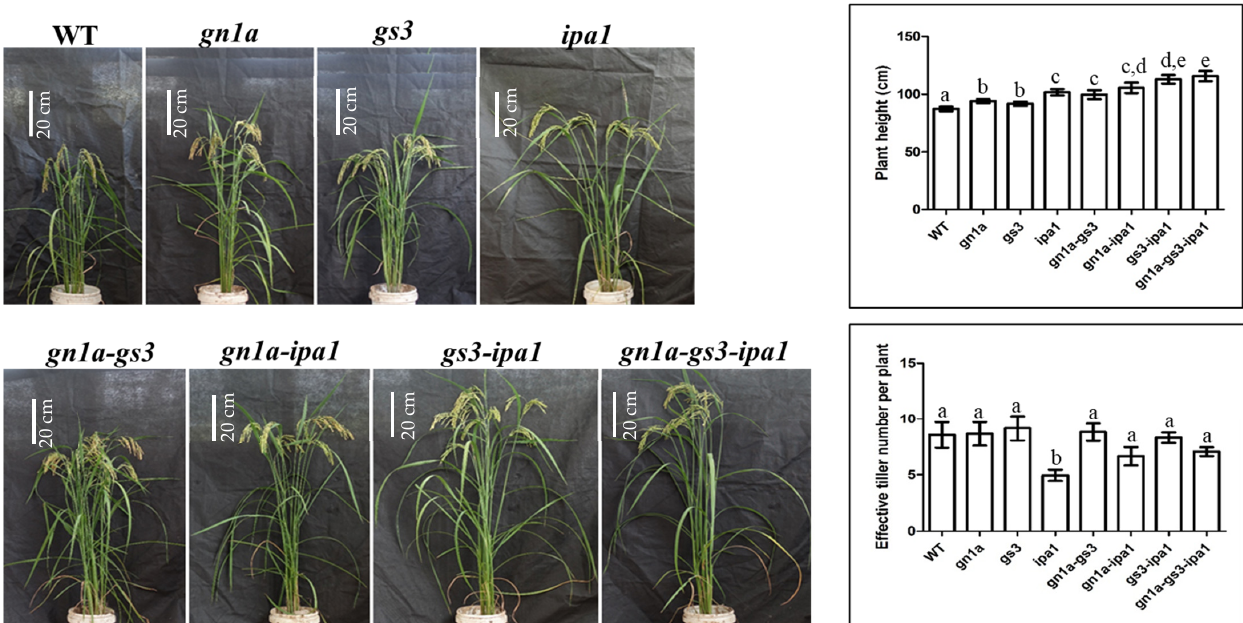
Figure 3. Representative plant profile, plant height, effective tiller number of the T3 generation. Means labeled with different lower letters are significantly different by the Duncan Multiple Range Test at p < 0.05.